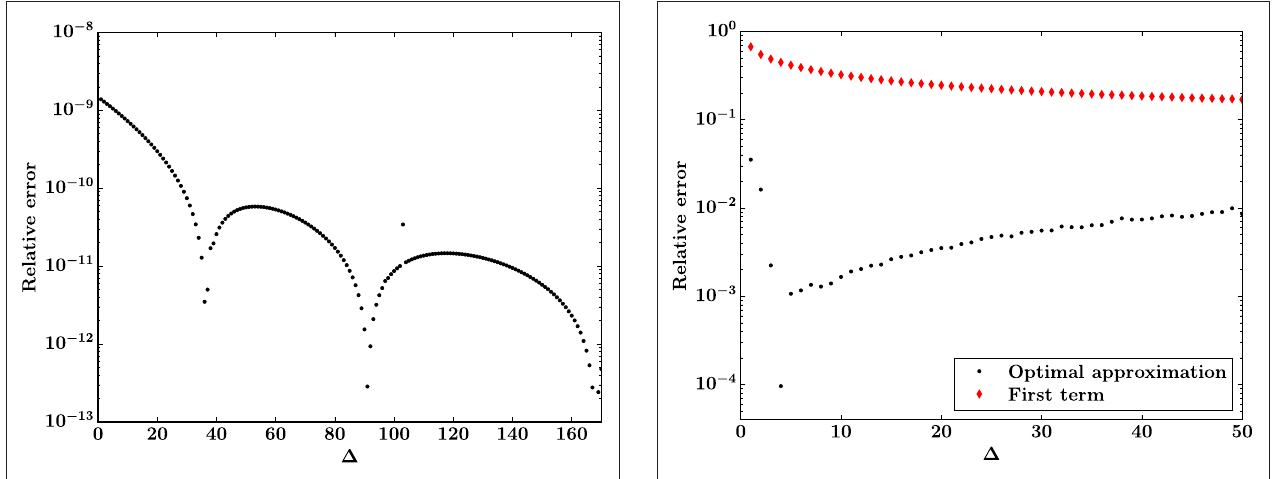
FIGURE 5 | Relative error for the burst distribution with respect to the exact result from Equation (14) for the optimal approximation from Equation (44) (with 13 available terms). The threshold distribution is a Weibull distribution with k 1 and t 0 0.8. = =